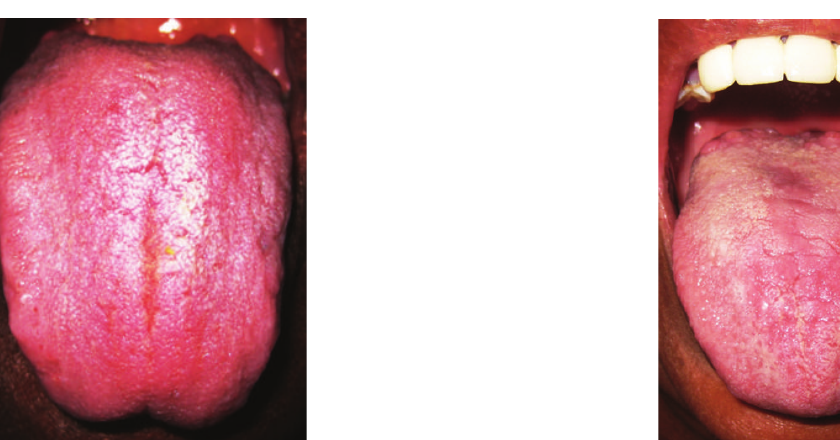
the central longitudinal fissure (branching tree